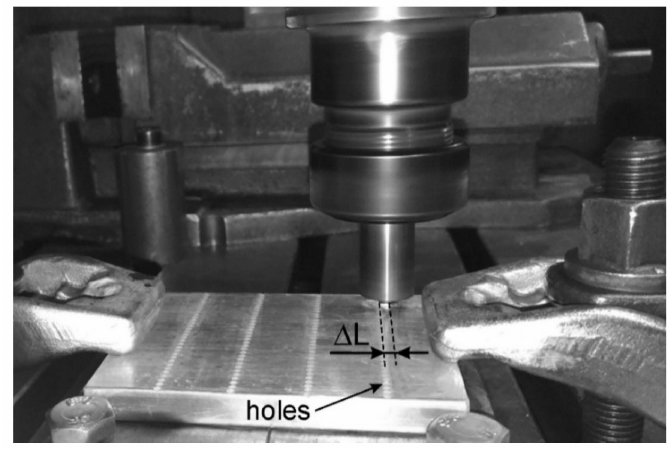
Figure 6. FSP stand (authors’ own